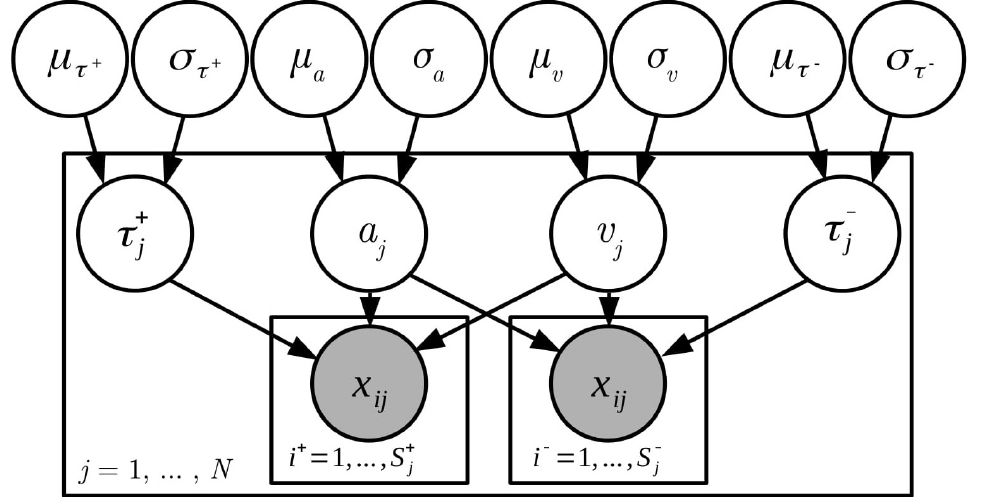
Figure 2. The hierarchical Bayesian model used for estimation of the diffusion model parameters. The inner plates relate to the trial level, the outer plate to the person level. On the outside are the group-level parameters. ν = drift date, a = boundary separation, τ + / − = non-decision time for correct and error responses, N = number of participants at a certain time point, S + / − = number of correct/error trials per person. x ij denotes a single trial. The figure does not show the effects on drift rate and boundary separation estimated at the group-level and person-level for the different experimental conditions and